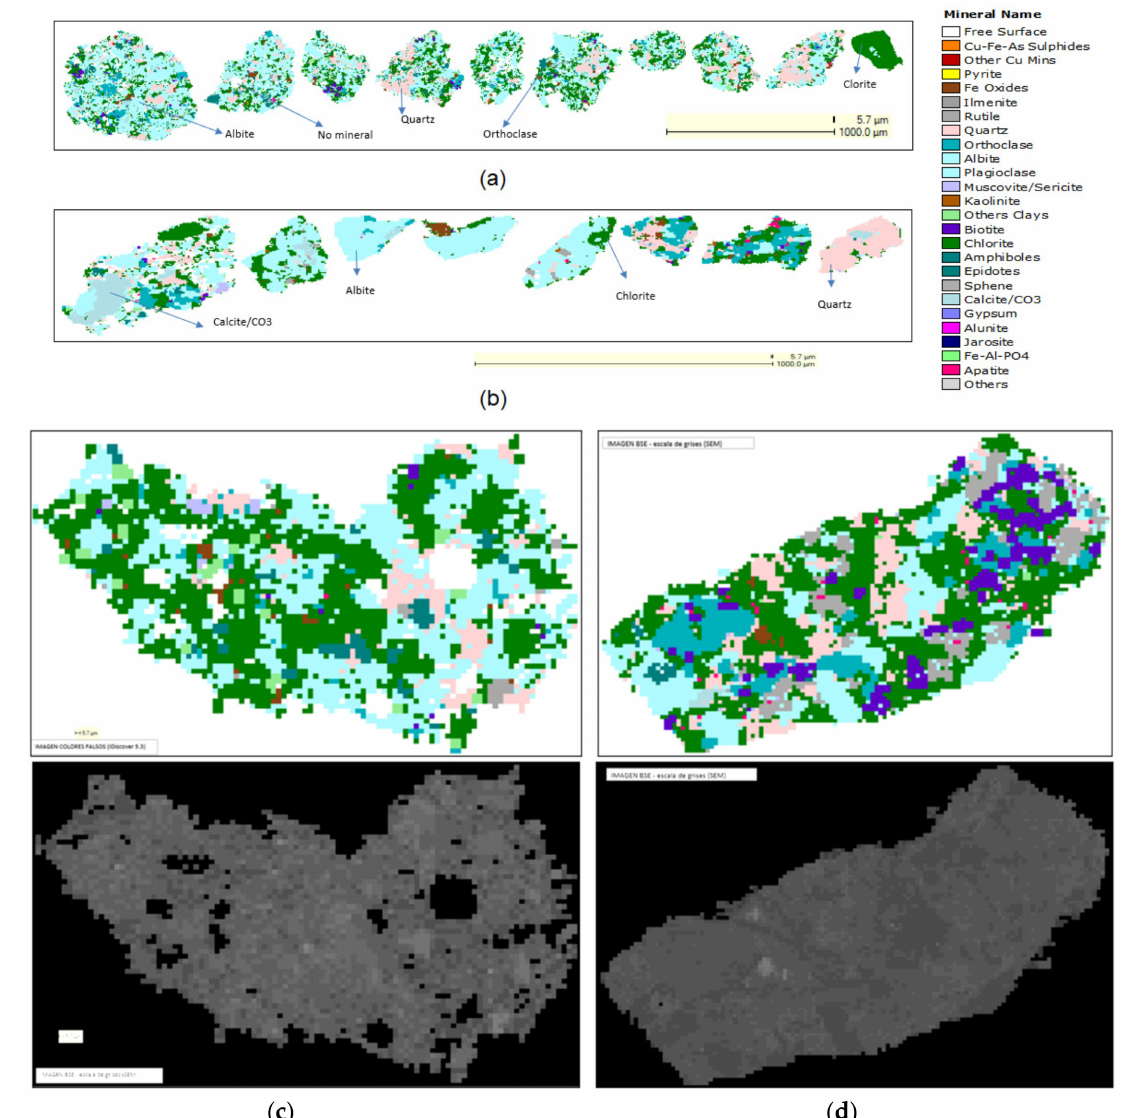
Figure 17. SEM images obtained using automated microscopy: ( a , c ) 100% NaOH and ( b , d ) 100%